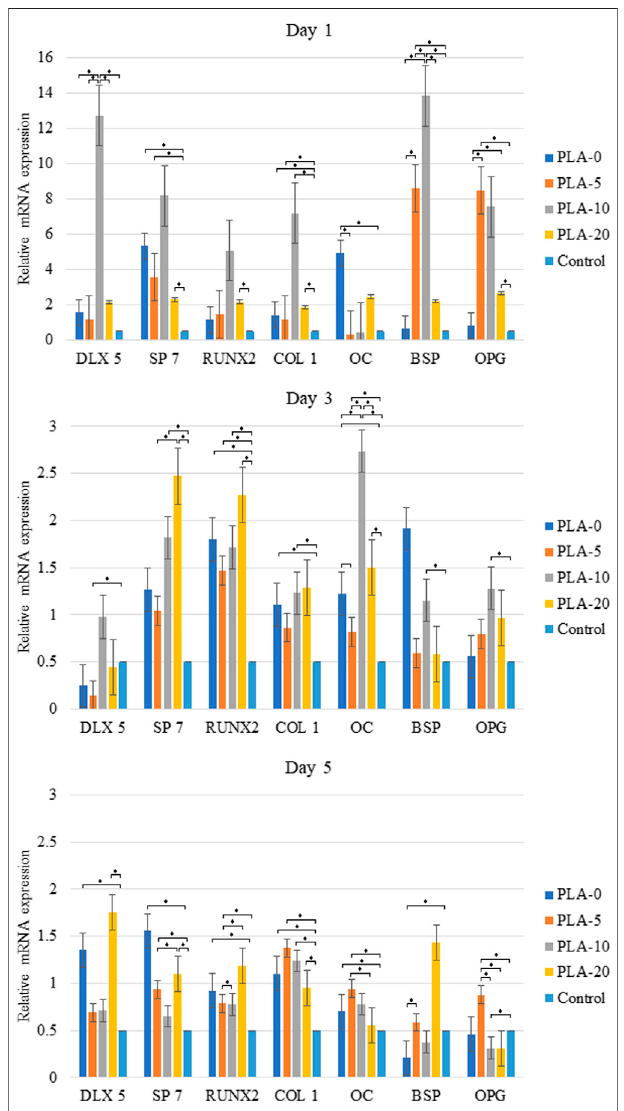
FIGURE 8 | Real-time polymerase chain reaction indicated higher osteoblastlineagegeneexpression fromcellsculturedonthePLA-10 fi lament medium at 5 days when compared to those cultured in DMEM (* p <